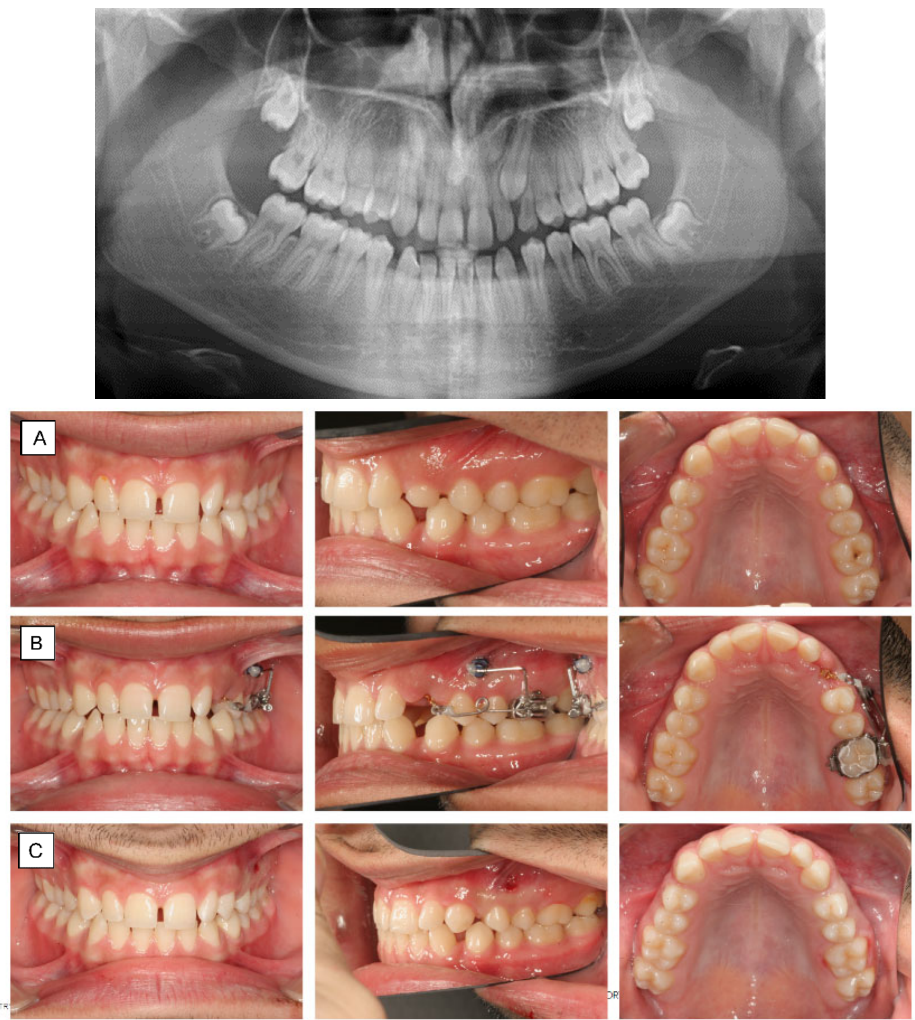
Figure 7. Panoramic x ‐ ray shows ectopic tooth 23 in a 16 ‐ year ‐ old patient with only slight resorption of 63 ( A ) Palatally impacted left maxillary canine. The patient was satisfied with the smile ‐ esthetic with the diastemas. Therefore, a sectional appliance was chosen for correction of position of 23 without changing neither the occlusion or position of the rest of the teeth. ( B ) Canine extrusion with 0.017 × 0.025 ″ TMA cantilever inserted into the tube of the molar, activated for extrusion and buccal displacement. TAD is applied to stabilize indirectly the molar (anchorage unit). ( C ) The canine is aligned into its final position.